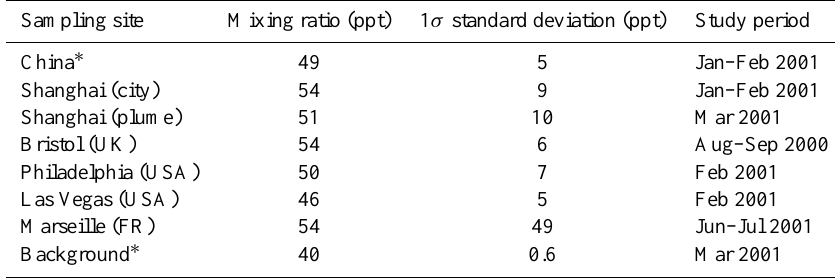
Table 3. MCF levels measured in various cities worldwide (adapted from Barletta et al., 2006). Sampling